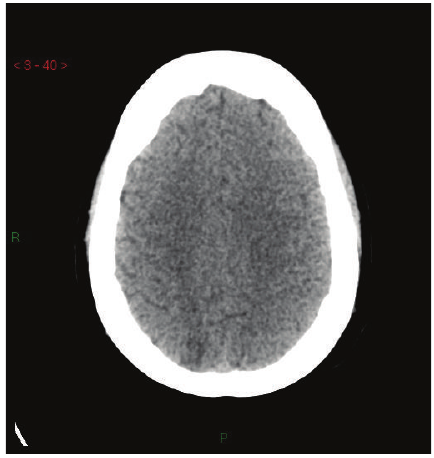
Figure 3: Case 2. Basal CT: hypodense cortical-subcortical lesions of the medial parietal region.